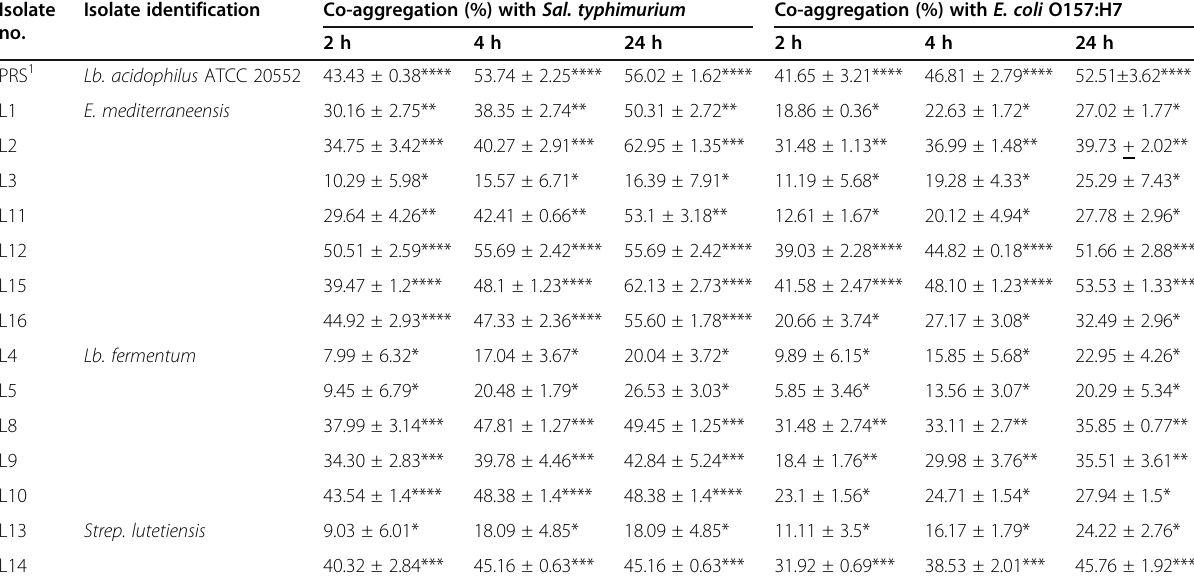
Table 8 Co-aggregation ability between isolated LAB and enteric bacteria Sal. typhimurium and E. coli O157:H7 Isolate